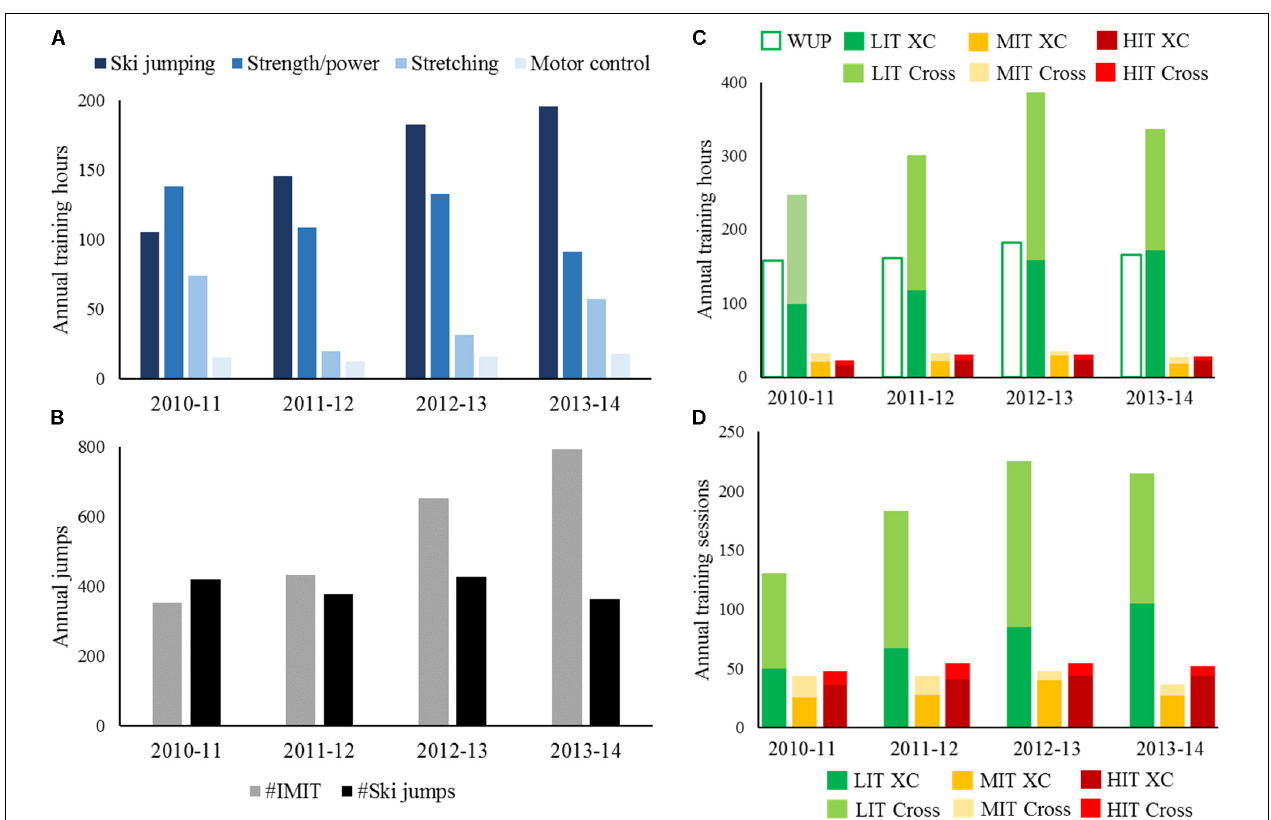
FIGURE 1 | Annual non-endurance training hours (A) and number of jumps (B) , as well as annual endurance training hours (C) and sessions (D) from the seasons 2010–2011 to 2013–2014 in an Olympic Champion in Nordic Combined. IMIT, dry-land imitation jump of a ski jump; WUP, time spent for warm-up, cool-down, and recovery; LIT, low-intensity training; MIT, moderate-intensity training; HIT, high-intensity training; XC, cross-country session employing skating technique; cross, endurance session not employing cross-country skating